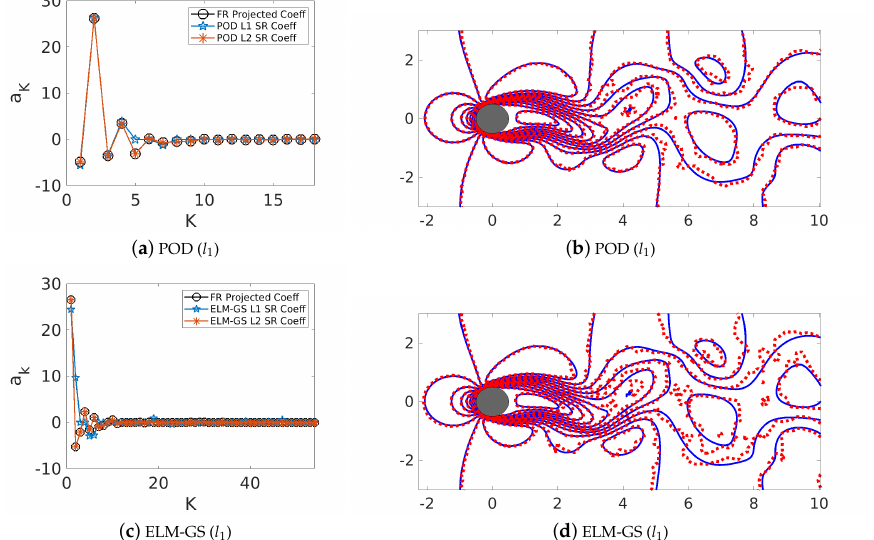
Figure 11. Normalized projected and reconstructed coefficient a ( a , c ) and The line contour comparison of the streamwise velocity between the actual CFD solution field (blue) and the energy-based SR reconstruction (red) using the l 1 SR algorithm for both POD and ELM-GS-based reconstruction ( b , d ) at K ∗ = 9, P ∗ =